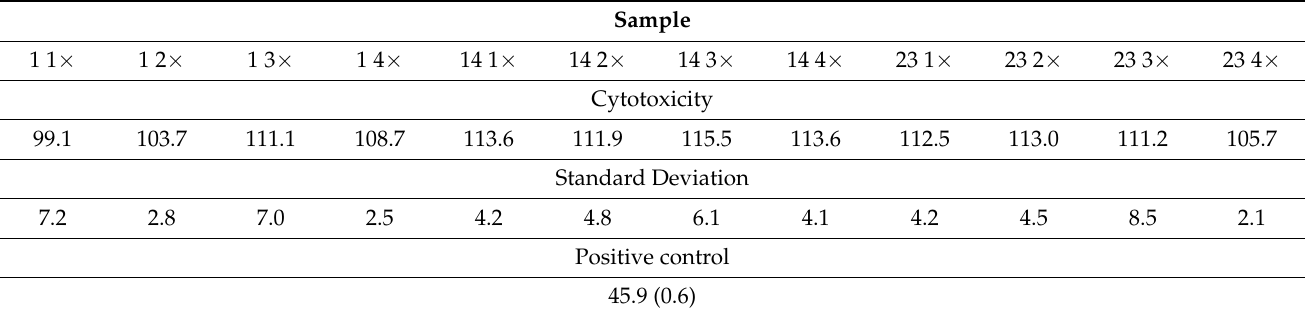
Table 9. Absorbance values of microplate wells in extract analysis.